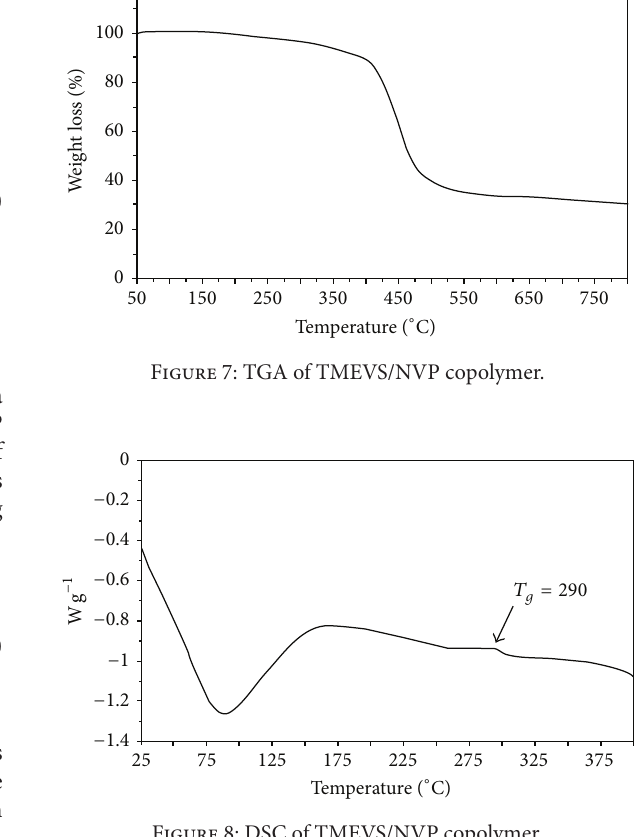
Figure 8: DSC of TMEVS/NVP